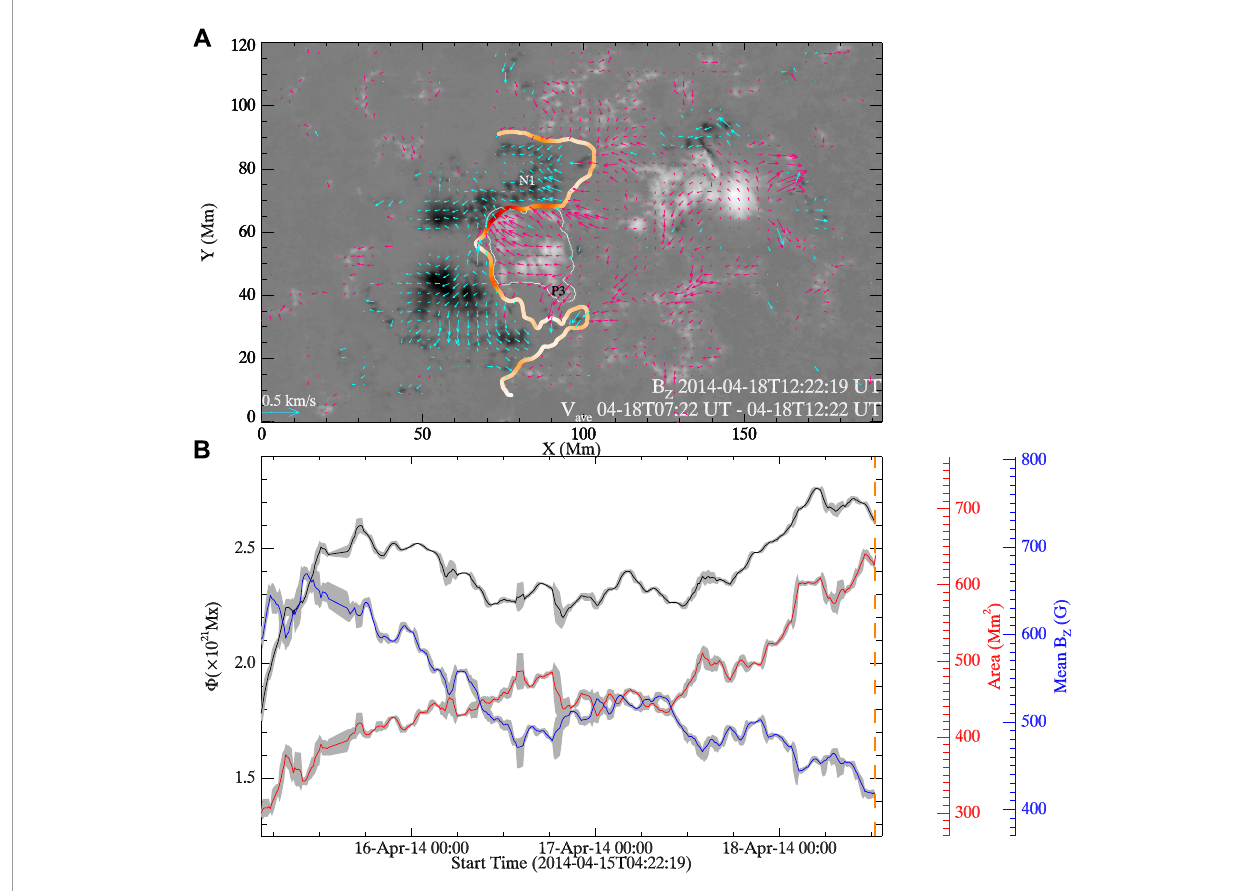
FIGURE 5 (A) Horizontal velocity field ( V ave ) averaged in 5 hours prior to the M7.3-class flare. The magenta arrows are for the positive flux, while the cyan arrows are for the negative flux. The PIL and boundary of polarity P3 have the same meaning as the ones in Figure 3 . (B) Unsigned magnetic flux, area, and mean B z of polarity P3. The gray regions mark the uncertainties of the parameters. The orange vertical line marks the start time of the M7.3-class